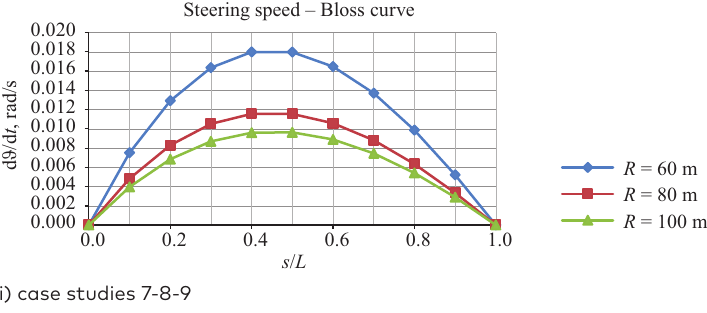
Figure 5. Kinematic comparison with the variation of the exit curve